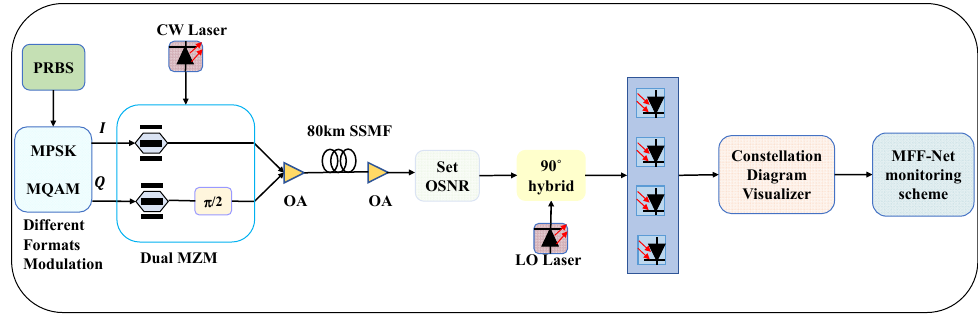
Figure 4. Simulation setup of the coherent optical communication system. PRBS, pseudo-random binary sequence; CW laser, continuous wave laser; Dual MZM, dual Mach–Zehnder modulator; OA, optical ampli fi er; LO, local oscillator.